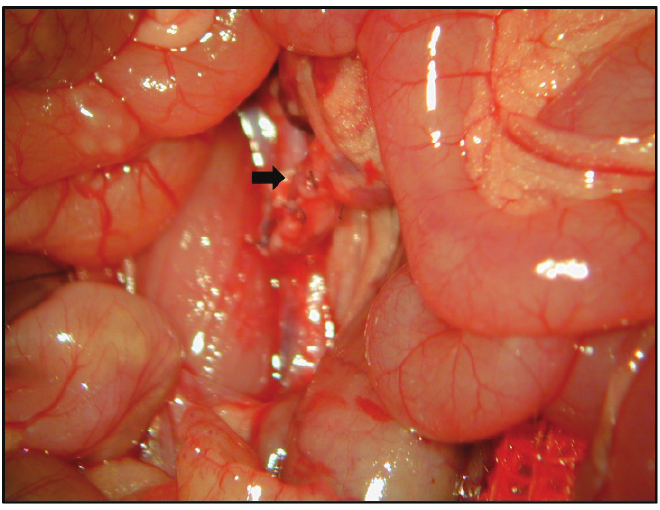
FIGURE 4 – Graft after reperfusion . The arrow points to the aotomesenteric conduit and donor’s portal vein.